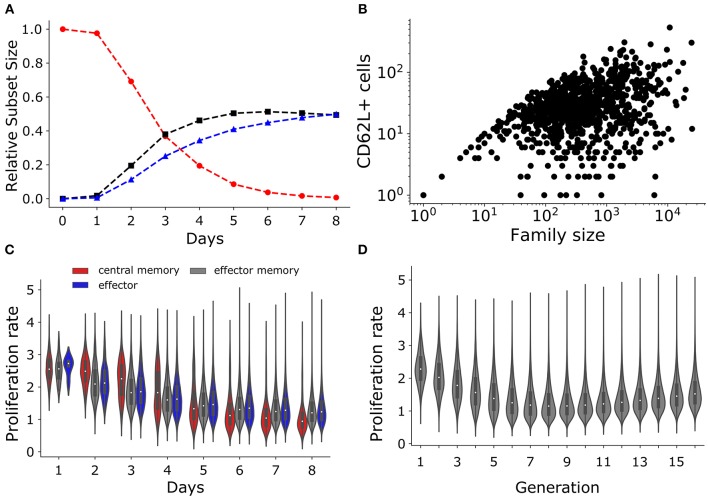
T cell subset dynamics. (A) Temporal dynamics of T cells: central memory cells (CD62L+CD27+; red); effector memory (CD62L−CD27+; black) cells; and effector (CD62L−CD27−; blue) cells. (B) Number of CD62L+ cells as a function of family size. (C) The violin plot shows the changes in the rate of proliferation (1/(time of division)) over time for T cell subsets: central memory cells (CD62L+CD27+; red); effector memory (CD62L−CD27+; gray) cells; and effector (CD62L−CD27−; blue) cells. (D) The violin plot shows the rate of proliferation as a function of generation or number of divisions.